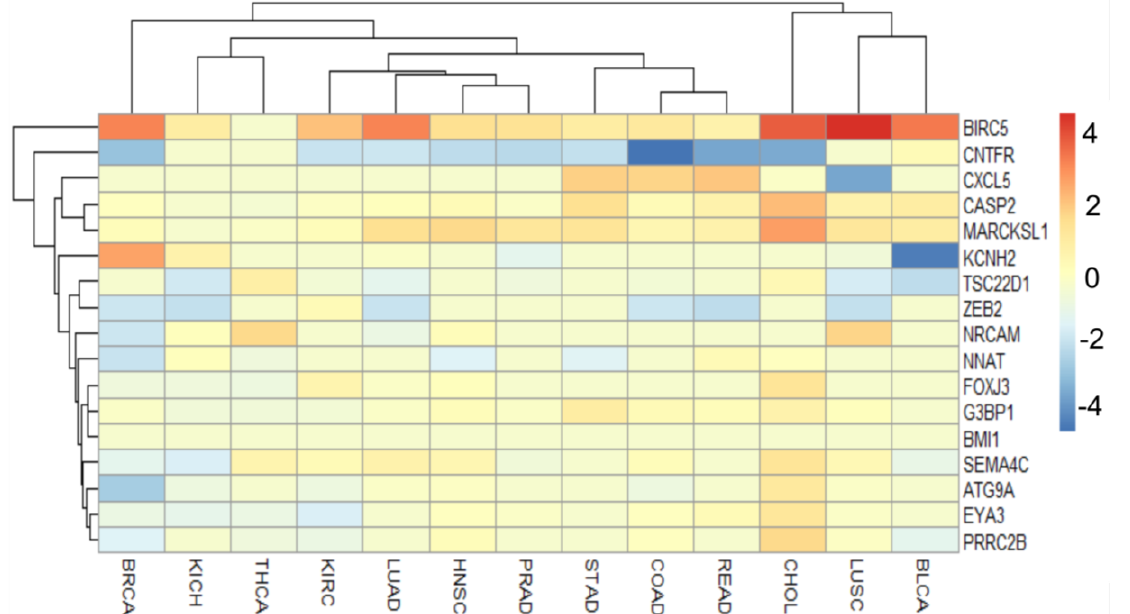
Figure 7. Heatmap representing miR-708-validated targets expression (shared at least between two databases) comparing tumor samples to normal samples. TCGA cohorts are represented in the columns and the individual genes in the rows. Data are represented in log2FC and genes with values equal to zero indicates a significant difference was not observed between tumor and normal samples. The heatmap was elaborated using pheatmap R package version: 1.0.12.